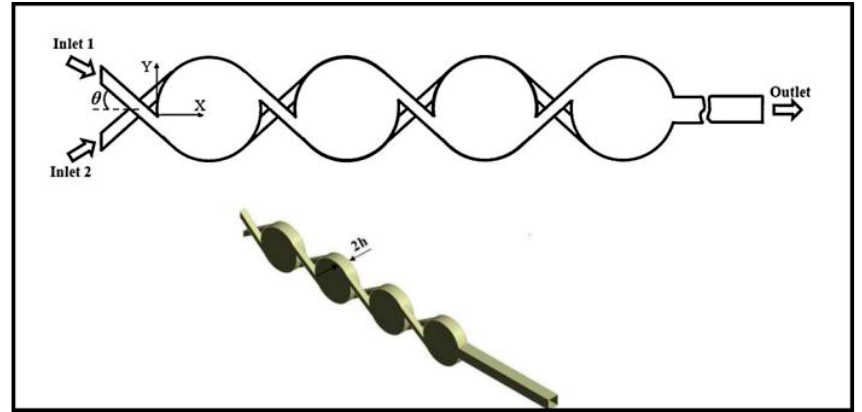
Figure 19. Schematic of the chamber based micromixers with circular chambers. Reproduced with permission from [110].